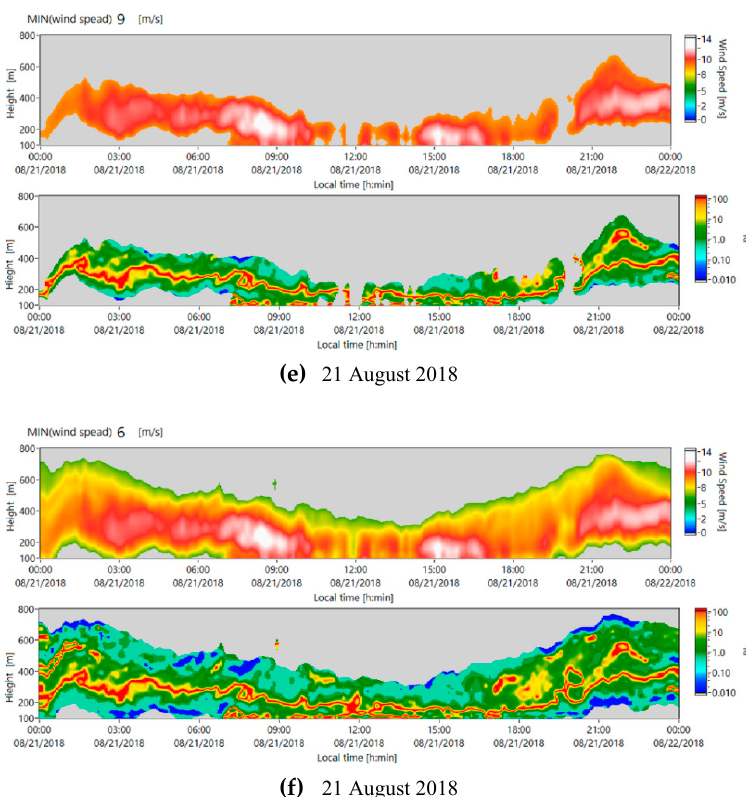
Figure 6. Spatiotemporal distributions of the wind velocity and the Richardson number bounded by isolines of a given minimal velocity of ( a ) 15, ( b ) 10, and ( c ) 5 m/s for measurements on 19 August and ( d ) 11, ( e ) 9, and ( f ) 6 m/s for measurements on 21 August 2018.